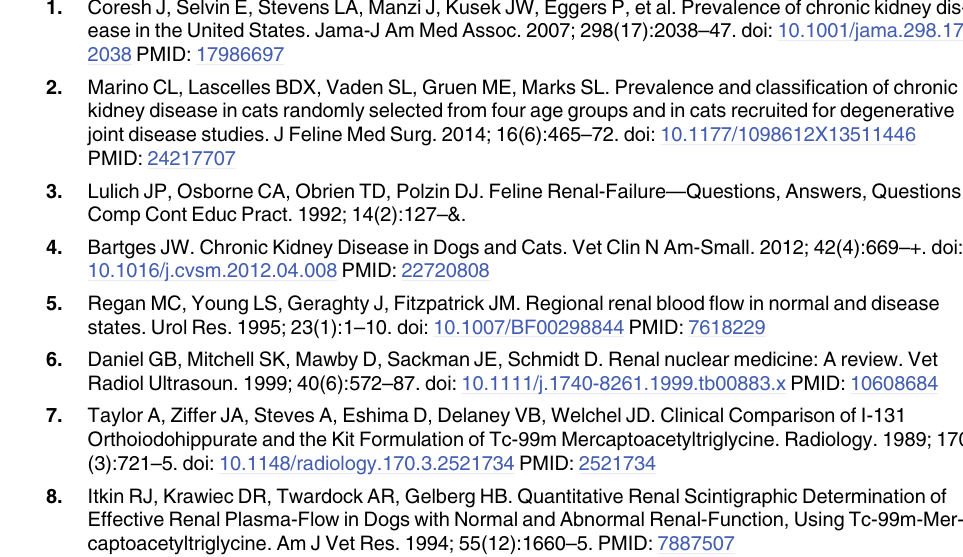
S2 Table. Mean and Standard Errors for 99m Tc-MAG uptake and kidney-to-heartratio (K/A) for the left and right kidney separately.